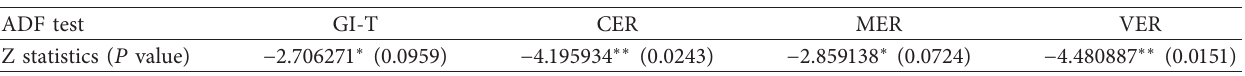
Figure 3: Comparison of the measurement of two methods. Table 4: Unit root test results.